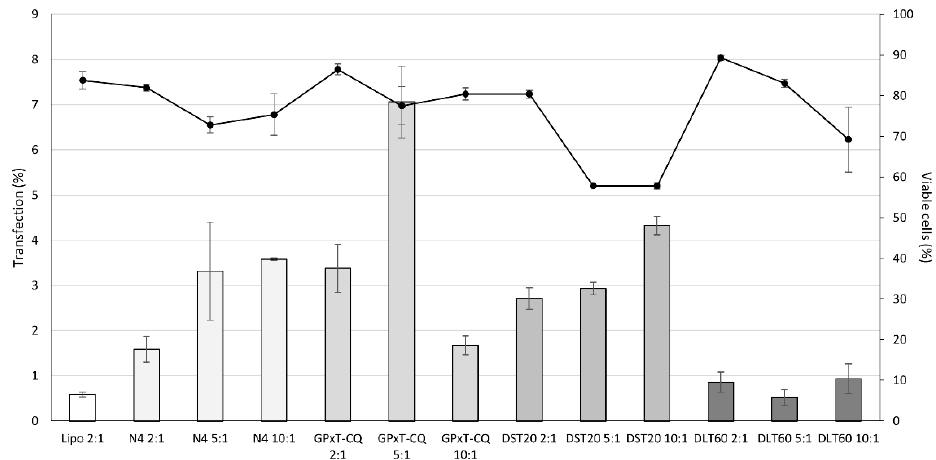
Figure 3. Screening of different nioplexes (N4, GPxT-CQ, DST20, and DLT20) at different cationic lipid/DNA ratios. The bars represent the transfection percentage measured by flow cytometry. Dots joined by the black line show cell viability. Each value represents the mean ± SD ( n = 3).